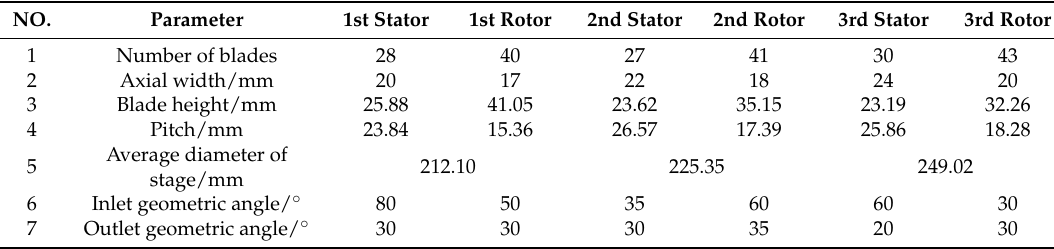
Table 3. Key structural